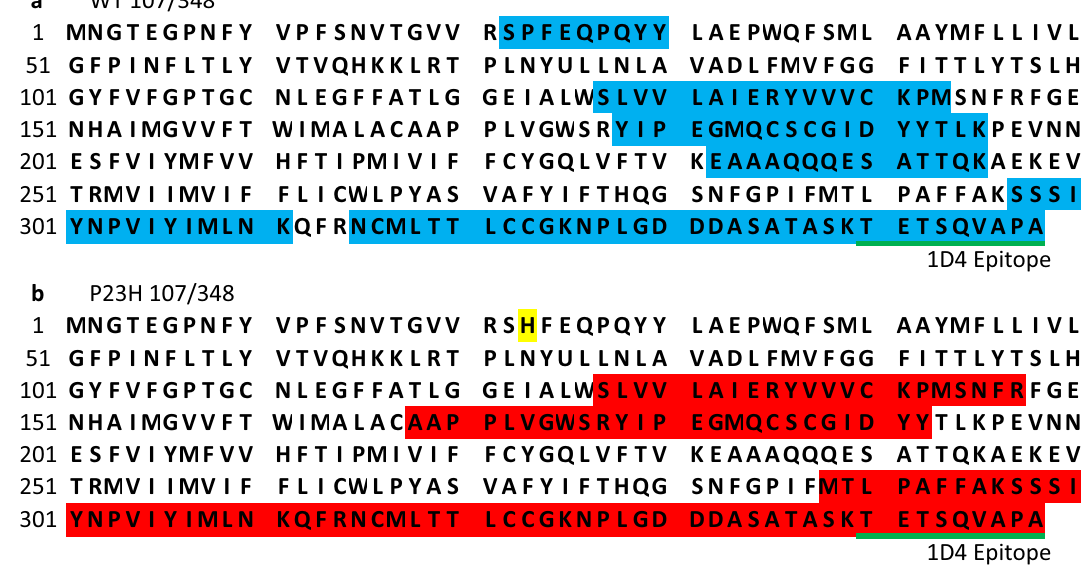
Table 1. Wild-type and P23H rhodopsin amino acid coverage. a. The wild-type rhodopsin sequence (107/348 amino acids) identified by mass spectrometry is highlighted in blue. b. The P23H rhodopsin sequence (107/348 amino acids) identified by mass spectrometry is highlighted in red. Highlighted in yellow is the P23H mutation. The location of the 1D4 anti-rhodopsin epitope is underlined in